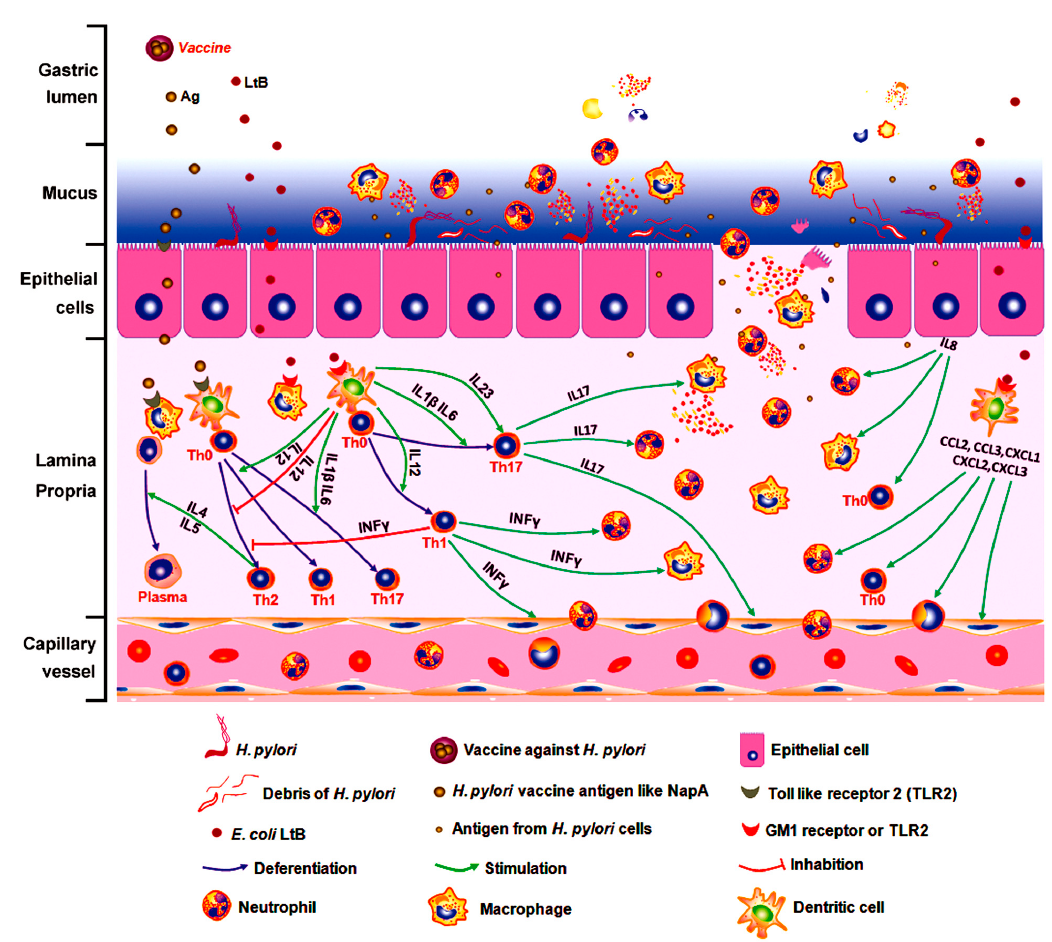
Figure 10. A novel explanation for LtB-adjuvanted oral vaccine-induced immune protection against H. pylori. To unveil the mystery of the vaccine-induced cellular immunity destroying H. pylori